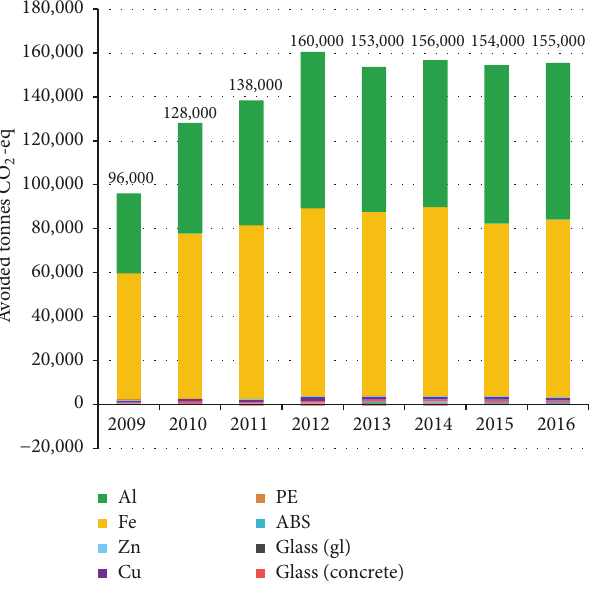
Figure 2: Avoided CO 2 emissions from material recycling in tonnes CO 2 -equivalents, per material, for the period 2009–2016. Numbers are